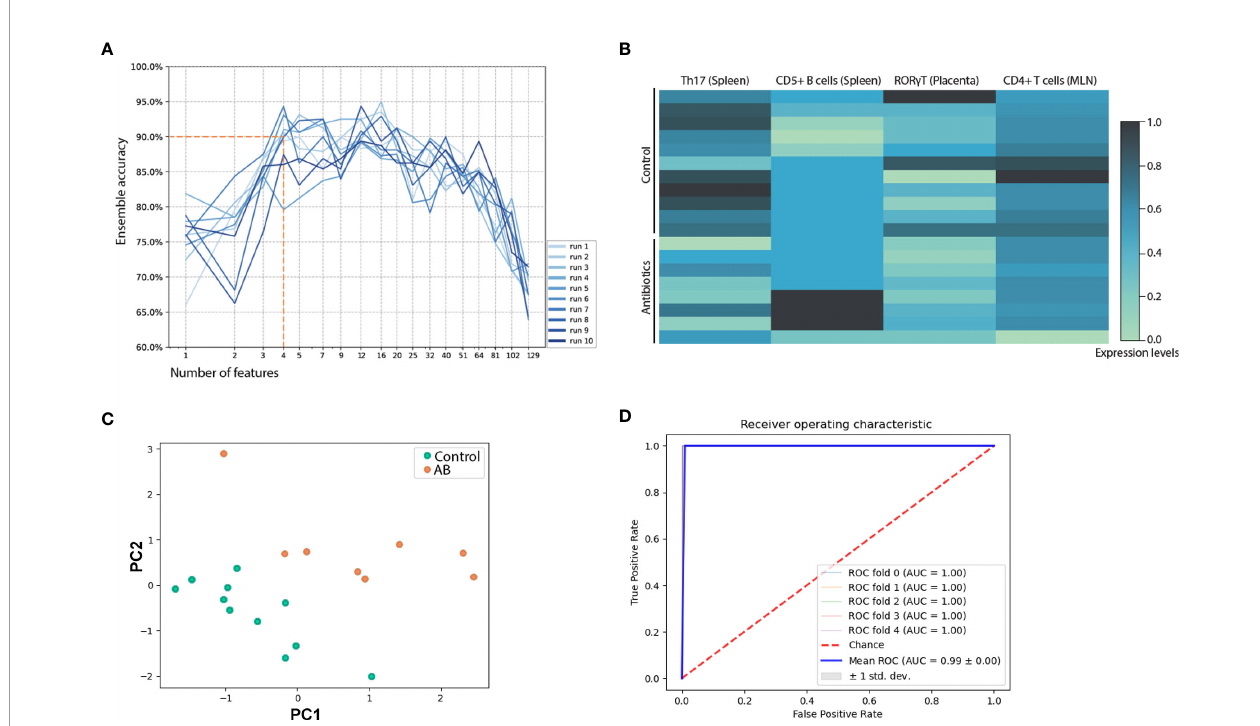
FIGURE 2 | Multivariate analysis of immunologic assessment across samples of spleen, mesenteric lymph node, inguinal lymph node, peritoneal cavity lavage fl uid, amniotic fl uid, and placenta. (A) Recursive feature reduction used in an ensemble machine-learning strategy to determine the number of top features needed to achieve robust (>90% accuracy) classi fi cation. (B) Top 4 immune features that allow for distinction between s. Normalized expression levels are depicted. (C) Principal component analysis based on the top 4 features that allowed for optimal classi fi cation. (D) Individual classi fi cation algorithms were run with the top 4 features of the ensemble ranking. The receiver operating curve of Ridge regression is shown. The same results were observed using Passive-Aggressive or Logistic regression. Additional receiver operating curves are depicted in Supplementary Figure S2 . AB, treated with antibiotics; MLN, mesenteric lymph